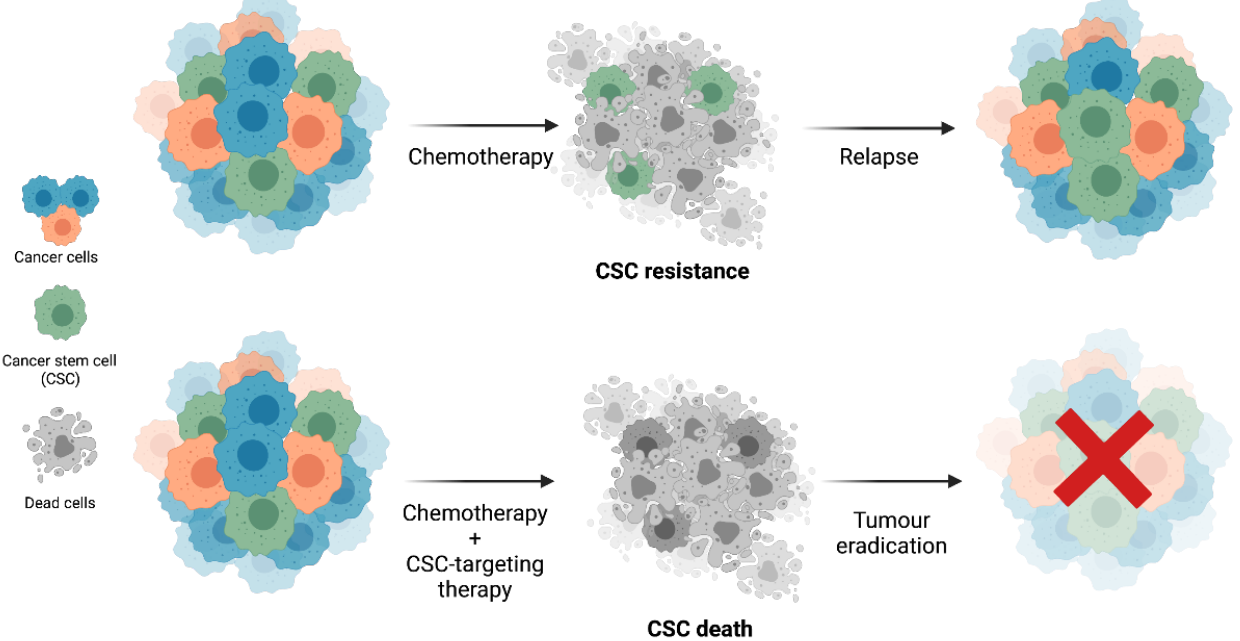
Figure 2. CSC resistance to conventional chemotherapy and the potential of CSC-targeting therapies for tumour eradication. The conventional chemotherapy that is currently in clinical practice targets highly proliferative cells and is ineffective against CSCs, which will ultimately be responsible for tumour relapses. The combination of standard chemotherapy with CSC-targeting therapies might be a promising strategy for tumour eradication. Biorender: https://biorender.com (accessed on 4 September 2021).